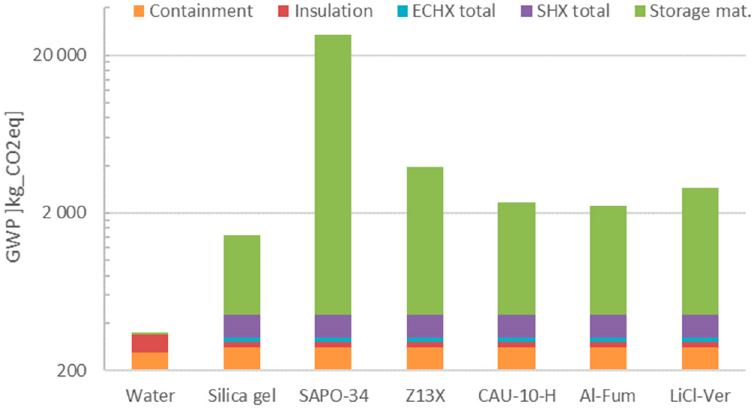
Figure 11. GWP of the single storage component elements (for 1 m 3 storages).